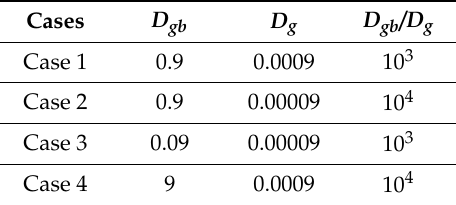
Table 2. Values of di ff usion coe ffi cients in di ff erent cases. D gb —grain boundary di ff usion coe ffi